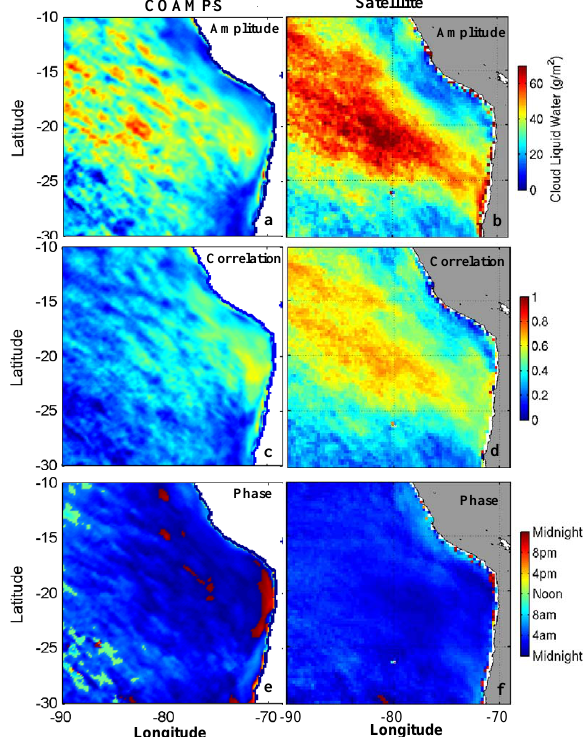
Fig. 4: Comparison of the harmonic analysis of LWP between the COAMPS forecasts (left column) and the satellite data (right column). (a) Predicted diurnal Fig. 4. Comparison of the harmonic analysis of LWP between the amplitude; (b) satellite diurnal amplitude; (c) correlation with the predicted har- COAMPS forecasts (left column) and the satellite data (right col- monic diurnal function; (d) correlation with the satellite diurnal function; (e) local umn). (a) Predicted diurnal amplitude; (b) satellite diurnal ampli- hours of the LWP maximum in the model ; and (f) local hours of the LWP maxi- tude; (c) correlation with the predicted harmonic diurnal function; mum in the satellite data. (d) correlation with the satellite diurnal function; (e) local hours of the LWP maximum in the model; and (f) local hours of the LWP maximum in the satellite